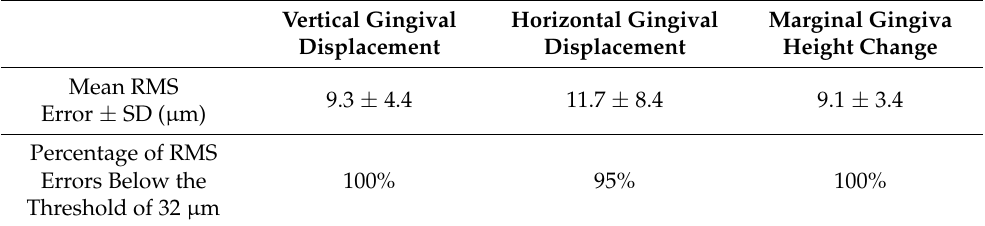
Table 6. Root mean square (RMS) error for the vertical gingival displacement analyses, horizontal gingival displacement analyses and for the marginal gingiva height change analyses (alignment of all first control models to the reference models).